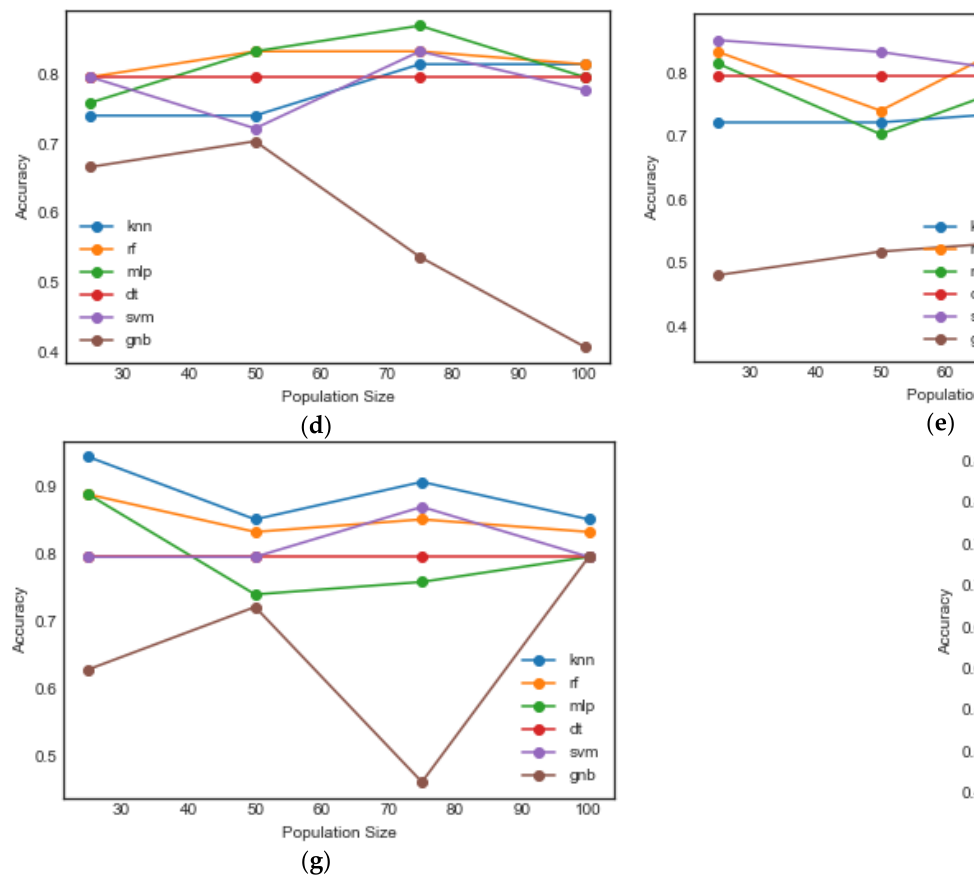
Figure 9. Classification accuracy of the KNN, RF, MLP, decision tree, SVM and Naïve Bayes models with population sizes of 25, 50, 75, and 100, using the ( a )